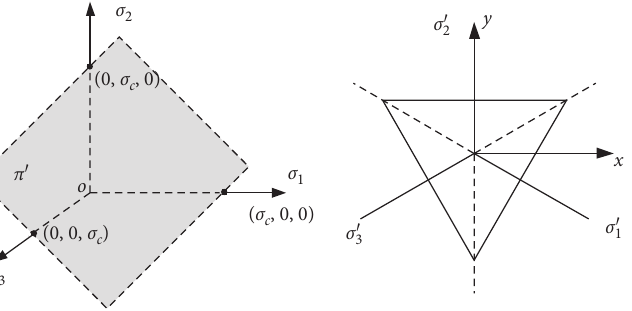
Figure 5: Yield curves on π ′